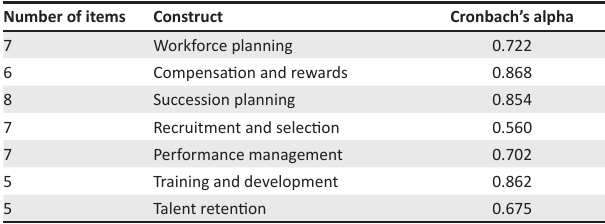
TABLE 1: Internal consistency using Cronbach’s